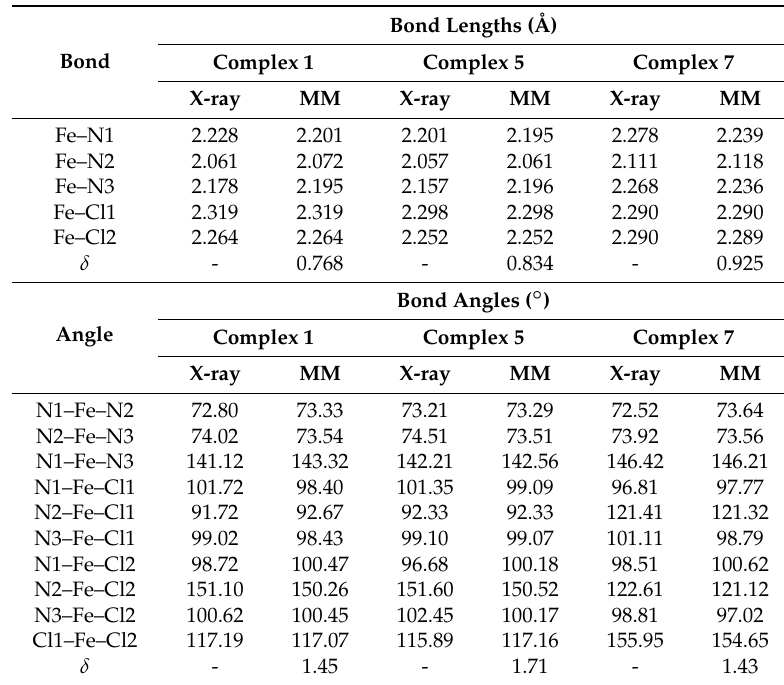
Table 1. The calculated bond lengths and bond angles compared with experimental crystal structures for complexes 1 , 5 , and 7 along with the values of standard deviation δ . MM, molecular mechanics.